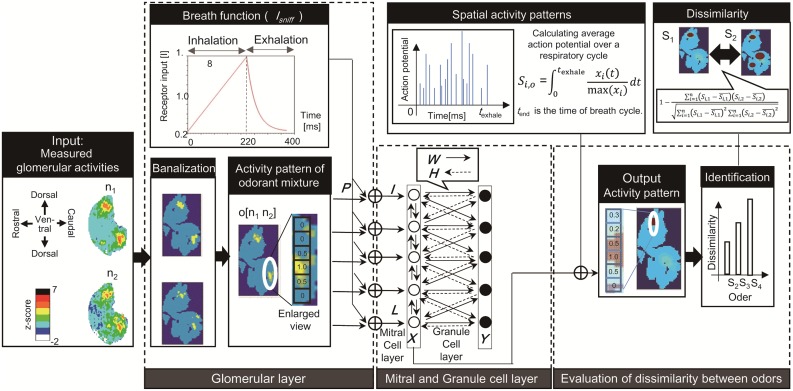
Schematic diagram of the proposed olfactory model.The model consists of a glomerular layer, mitral and granular layer, and a dissimilarity evaluation module. The model takes the glomerular activity patterns of odorants composing an odor as input, and considers respiration cycles to simulate the glomerular response to odorant mixture. The neural activity in mitral and granular cells is simulated based on the models proposed in a previous study [20, 21]. The dissimilarity evaluation module defines a dissimilarity index E and compares the activity patterns evoked in the mitral layer by different input odorant mixtures.